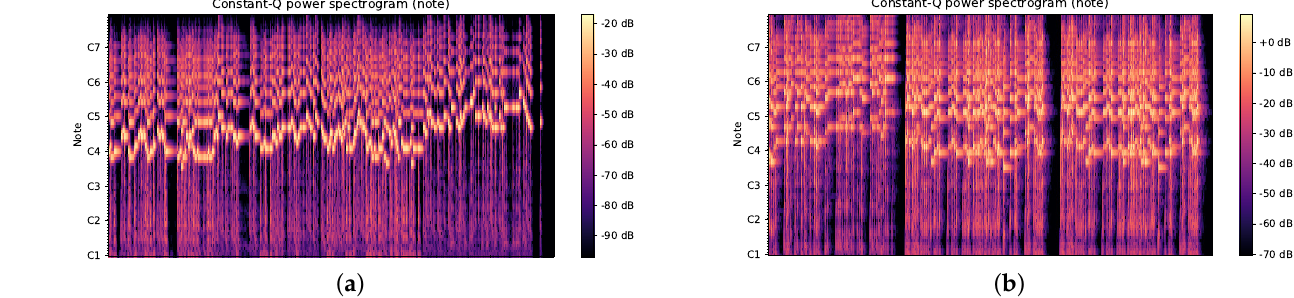
Figure 16. Constant-Q power spectrogram of 3D-SCN ( a ) and BoYaTCN ( b ). The piano roll visualization demonstrated the duration and pitch information